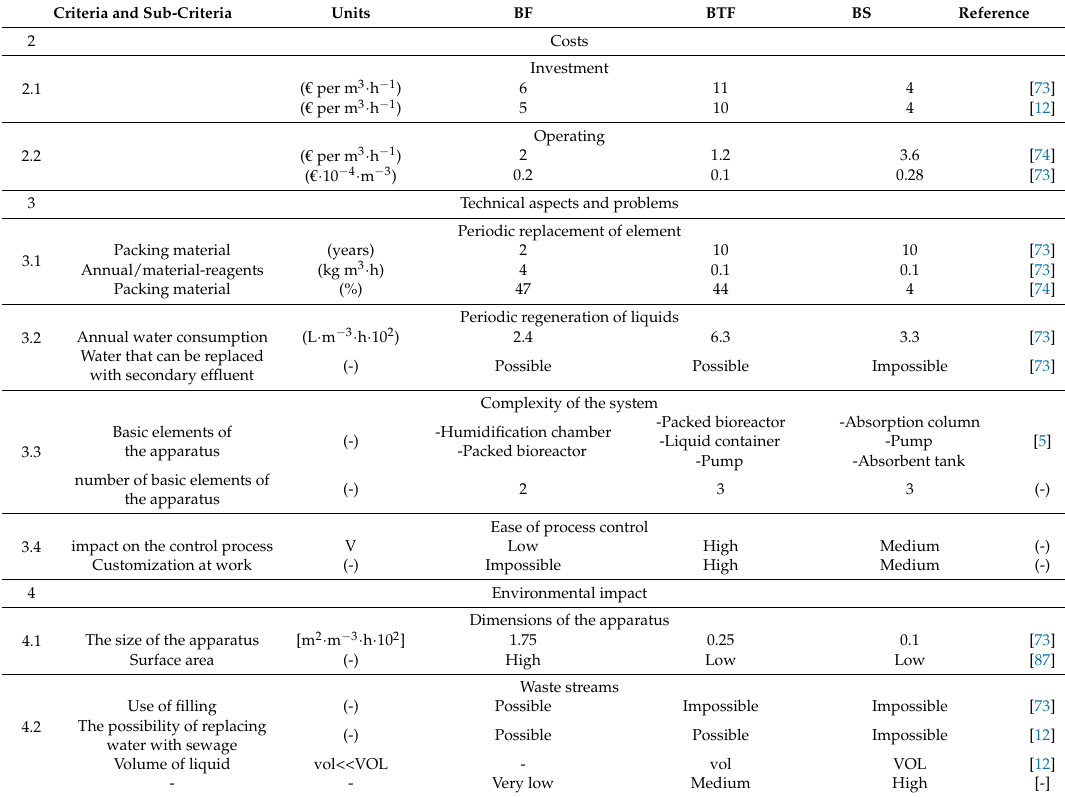
Table 3. Literature data for determining the values of sub-criteria 2.1–4.2 (investment and operating costs are presented for a flowrate 50,000 m 3 h − 1